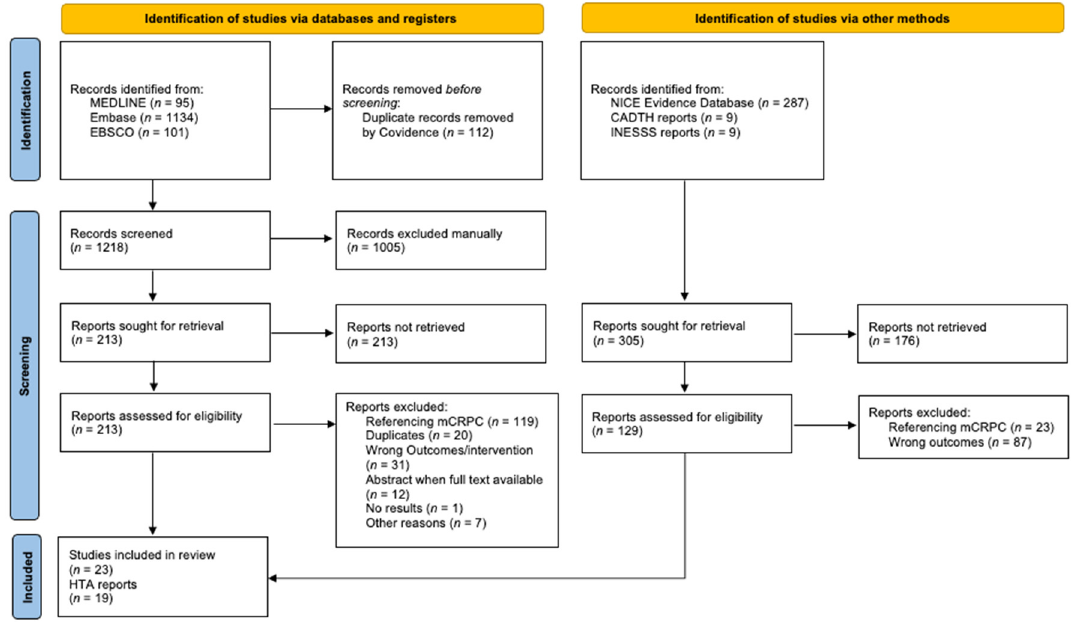
Figure 1. PRISMA flow diagram. Abbreviations: CADTH: Canadian Agency for Drugs and Technologies in Health, HTA: health technology assessment, INESSS: Institut national d’excellence en santé et en services sociaux, NICE: National Institute for Health and Care Excellence, mCRPC: metastatic castration-resistant prostate cancer.